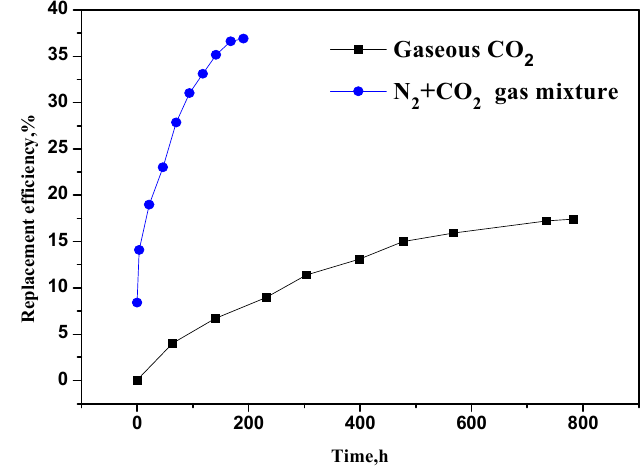
Figure 7. Variation of the replacement efficiency of CH replacement